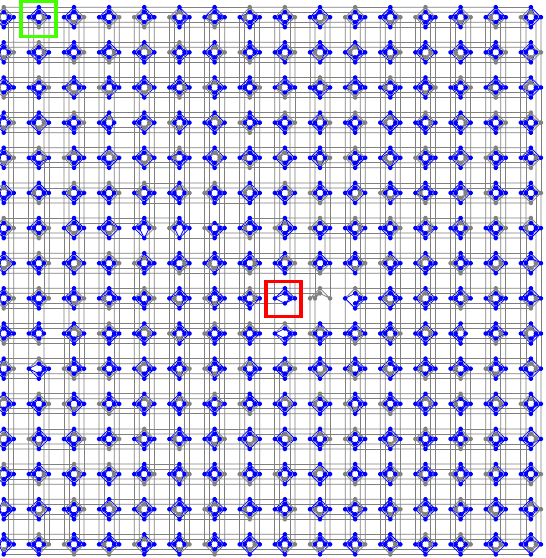
Figure 6. The Chimera graph for the LANL D-Wave 2000Q machine with 256 unit cells. Complete unit cell in green, and incomplete unit cell in red. Blue coloring on the connectivity graph shows the qubits and couplers that are used in the 255 disjoint clique-4